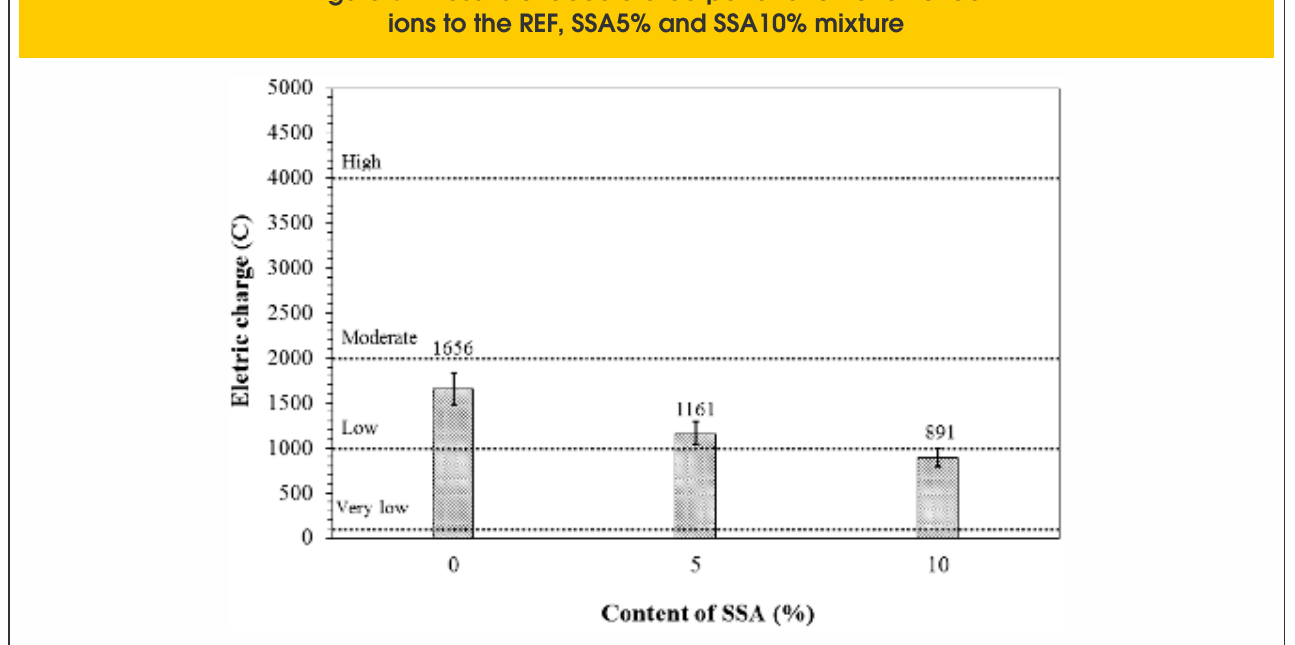
Figure 5 – Results of accelerated penetration of chloride